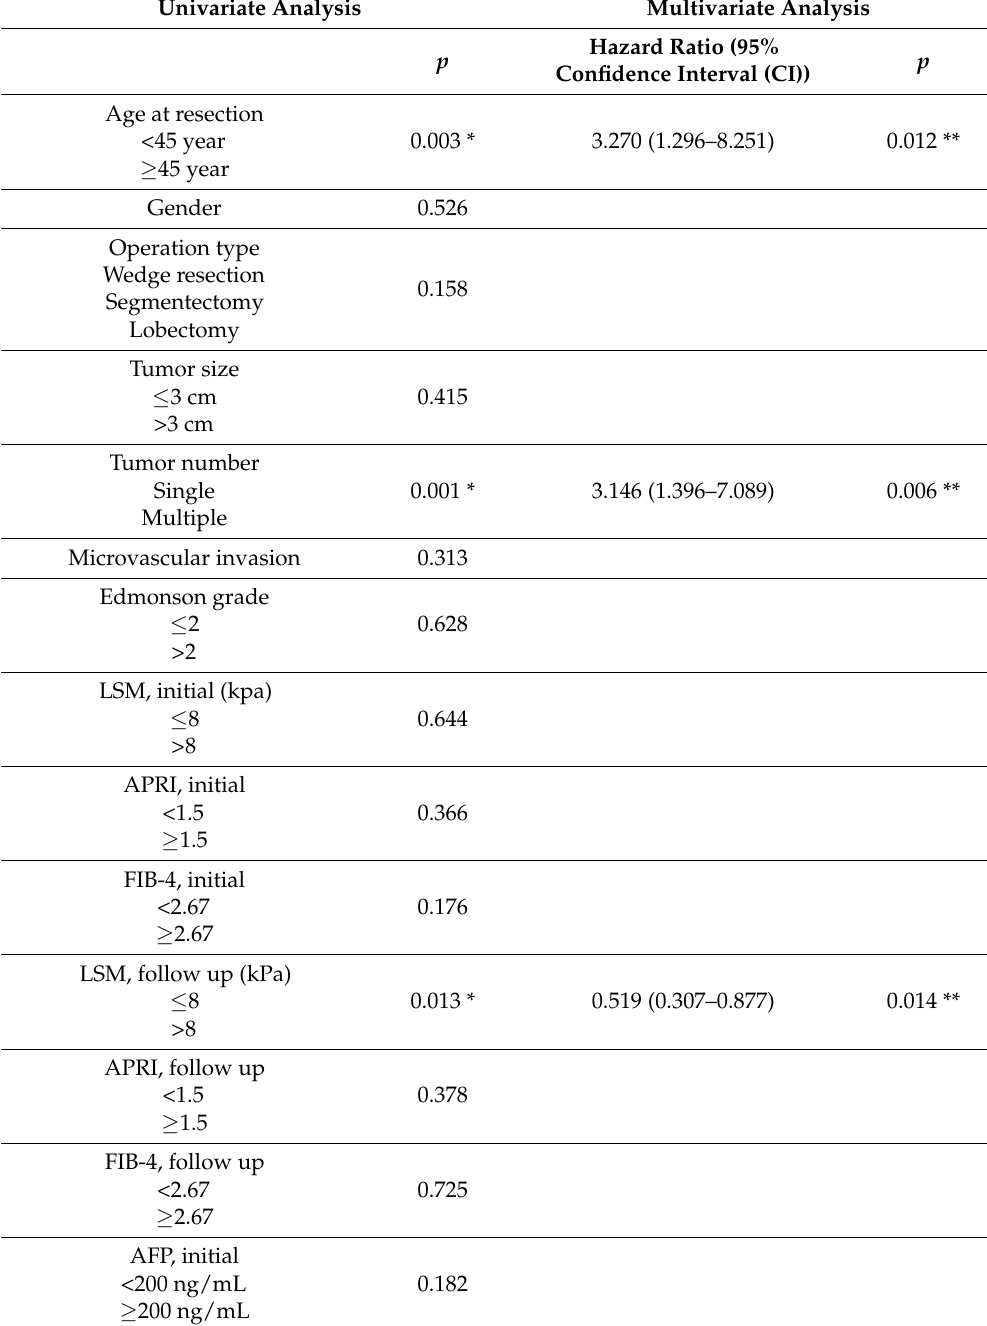
Table 3. Independent predictors of late recurrence after curative HCC resection in patients with pathologically confirmed liver cirrhosis under antiviral